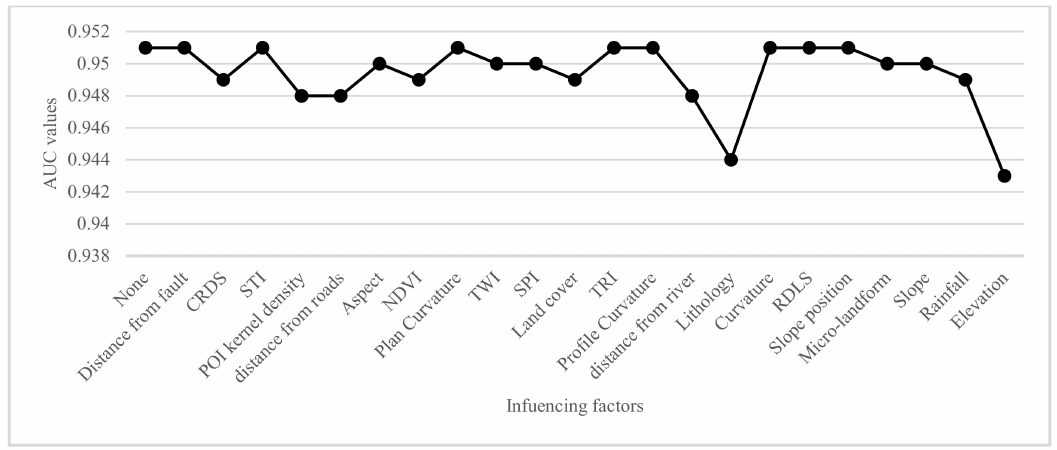
Figure 20. AUC values of RF model with di ff erent reduced landslide influencing